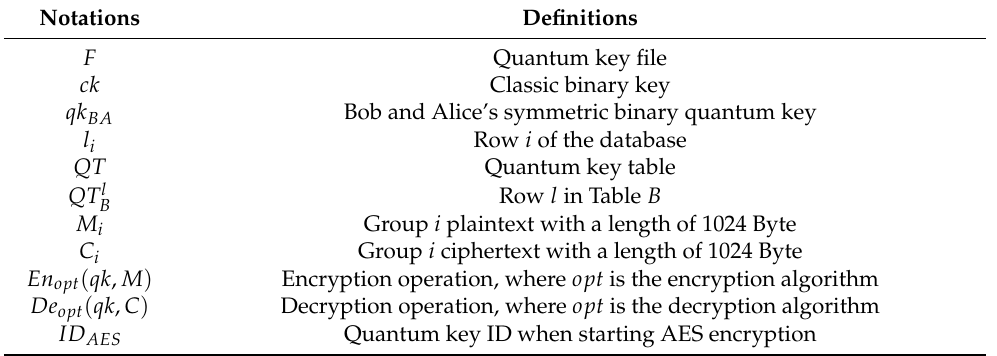
Table 1. Notations used in our